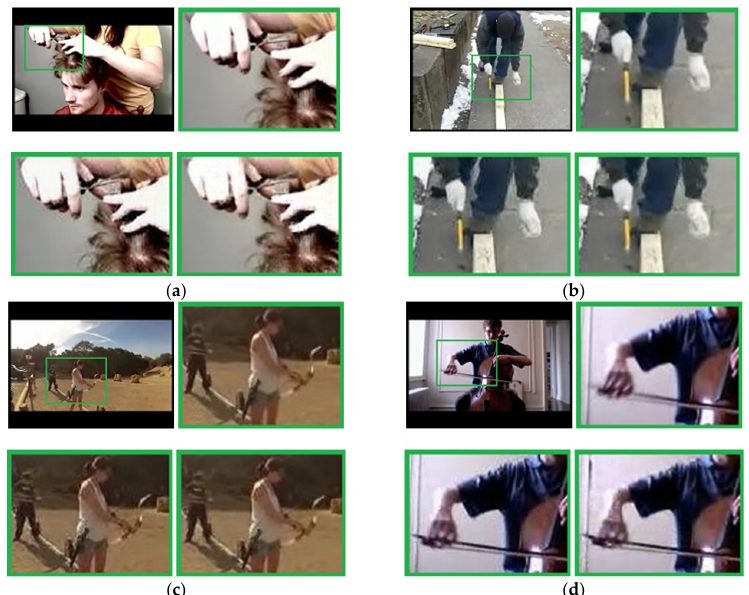
Figure 7. Experimental results on cross-domain action categories from the UCF101 dataset. For each group, the ground truth is shown in the first row, and the generated output of the proposed method is shown in the second row, in which the left one is the output without refinement, and the right one is the refinement output. Quality metrics for the generated output: ( a ) w/o refinement: PSNR = 30.56, SSIM = 0.834; with refinement: PSNR = 30.16, SSIM = 0.782; ( b ) w/o refinement: PSNR = 27.85, SSIM = 0.856; with refinement: PSNR = 28.51, SSIM = 0.852; ( c ) w/o refinement: PSNR = 30.68, SSIM = 0.849; with refinement: PSNR = 32.78, SSIM = 0.839; ( d ) w/o refinement: PSNR = 34.03, SSIM = 0.896; with refinement: PSNR = 34.39, SSIM = 0.845.